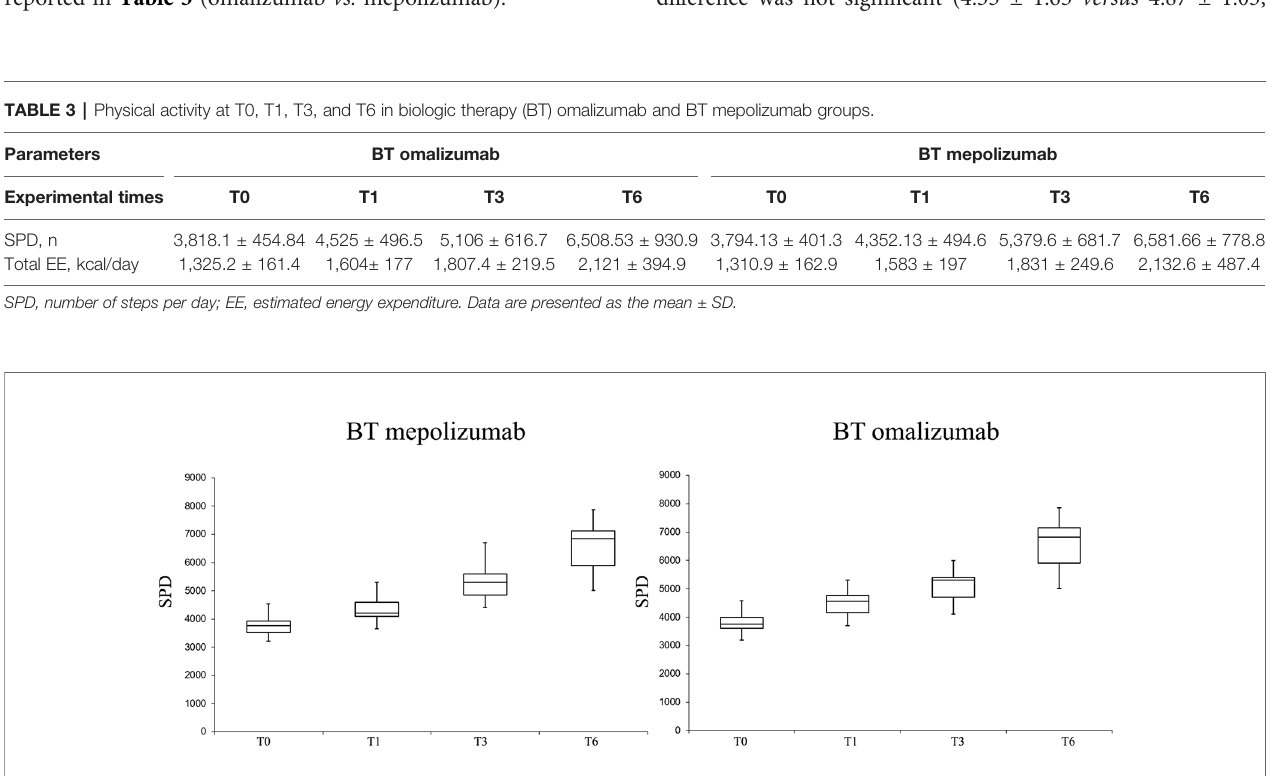
FIGURE 3 | Number of steps per day (SPD) variations at different follow-ups in the biologic therapy (BT) omalizumab group and in the BT mepolizumab